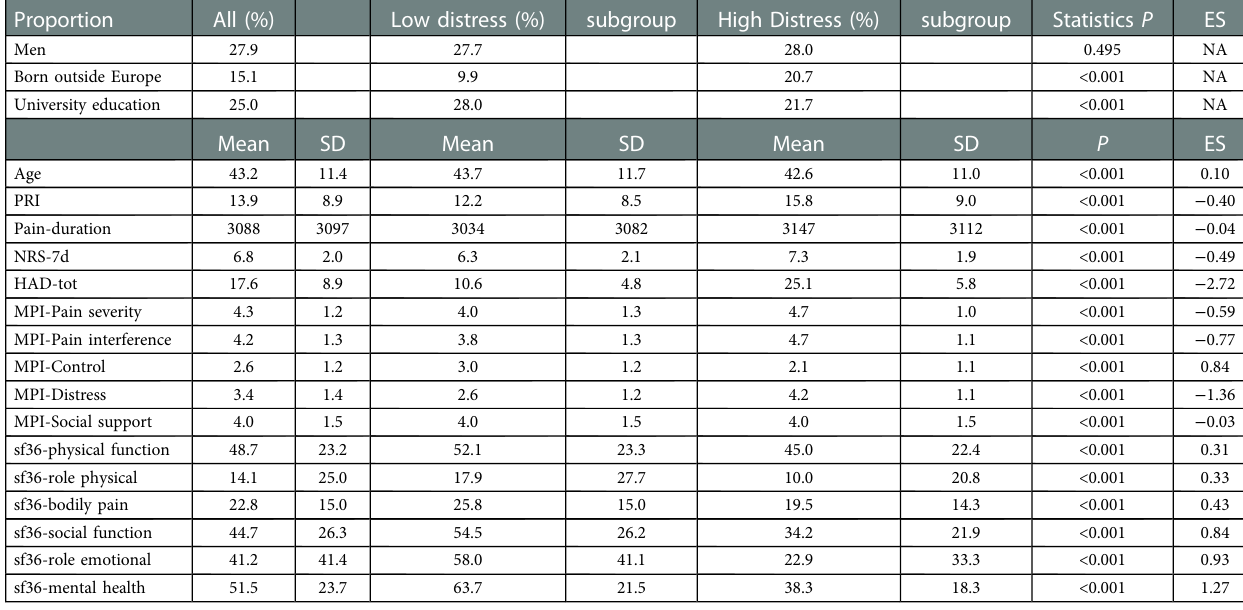
TABLE 3 Mean and SD for the imputed data for the total cohort ( N =40,186 for all variables) (left). On the right is shown the two subgroups (i.e., Low distress ( N =20,986) and High distress ( N =19,288). Furthest to the right are shown the results of the comparisons between the two subgroups ( P -value and effect size ES (Hedges ’ g ) for the quantitative